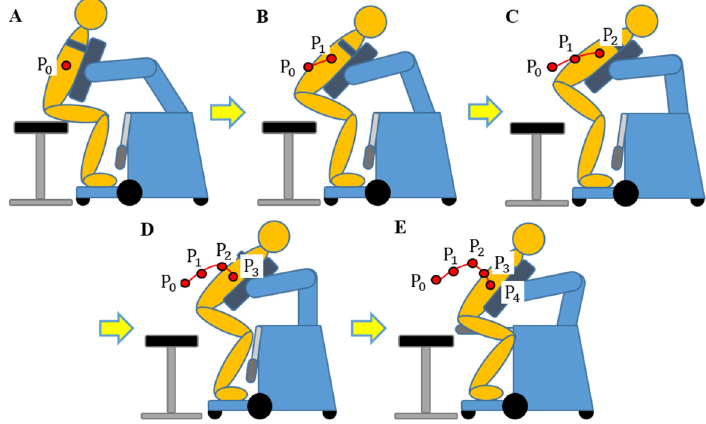
Figure 6. The motion planning of the nursing-care robot for the transfer task.